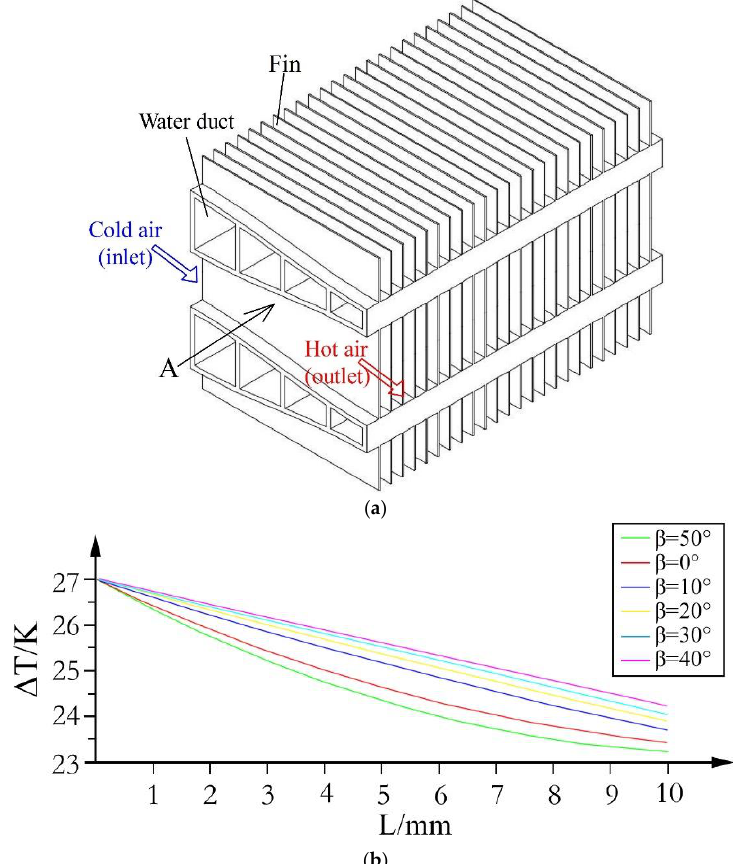
Figure 1. Curved flow channel and temperature difference distribution in a trapezoidal flow channel. ( a ) Curved flow channel; ( b ) temperature difference distribution in a trapezoidal flow channel [5].